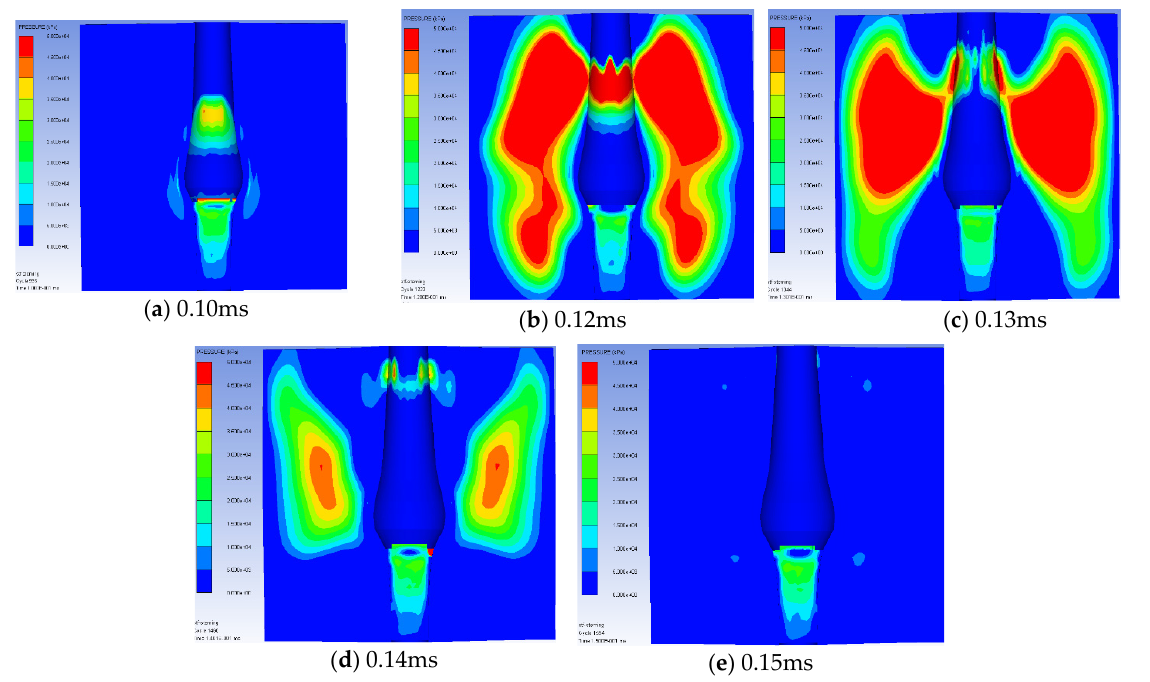
Figure 18. Pressure contour for the lead block model at the initial step (STF stemming cases).